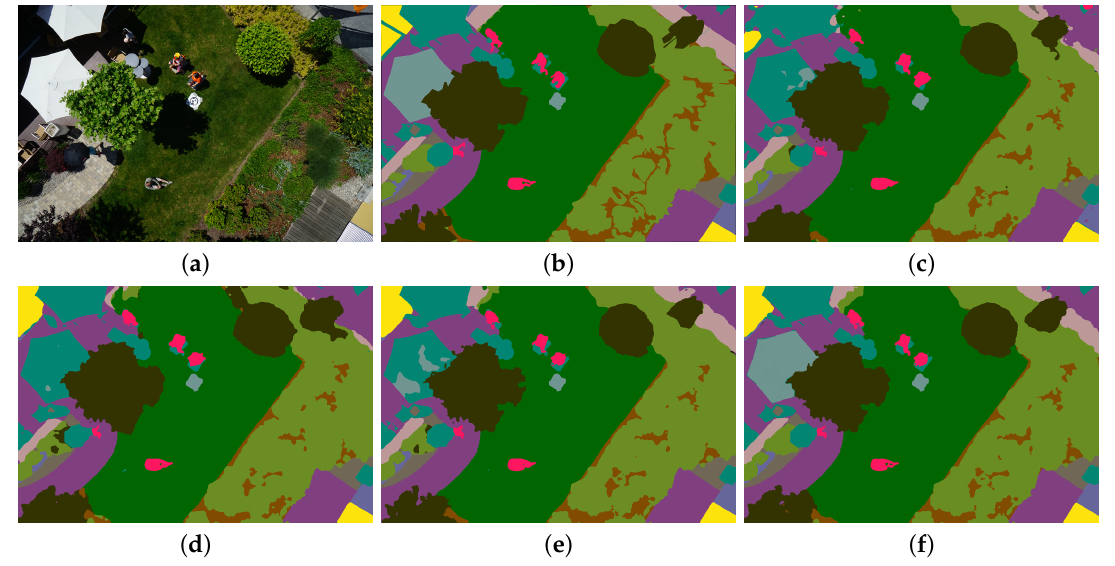
Figure 7. Visualization results of different methods on clean example test set in Semantic Drone dataset. ( a ) Original Images. ( b ) Ground Truth. ( c ) MCLNet [13]. ( d ) BSNet [14]. ( e ) SBANet [15]. ( f )